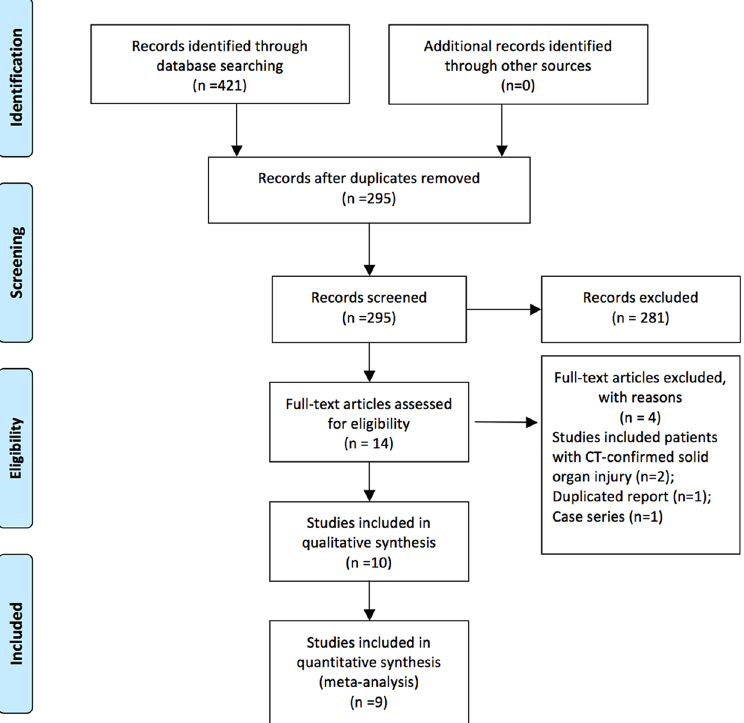
Figure 1. PRISMA flow chart of study inclusion. The initial search identified 421 citations. After removing duplicates, there remained 295 citations. A number of 281 citations were excluded, and the remaining 14 citations were reviewed for the full text. Four citations were excluded because two studies included only patients with CT-confirmed solid organ injury, one was duplicated report, and one is a case series report. As a result, a total of 10 studies were included in the study and 9 were included for